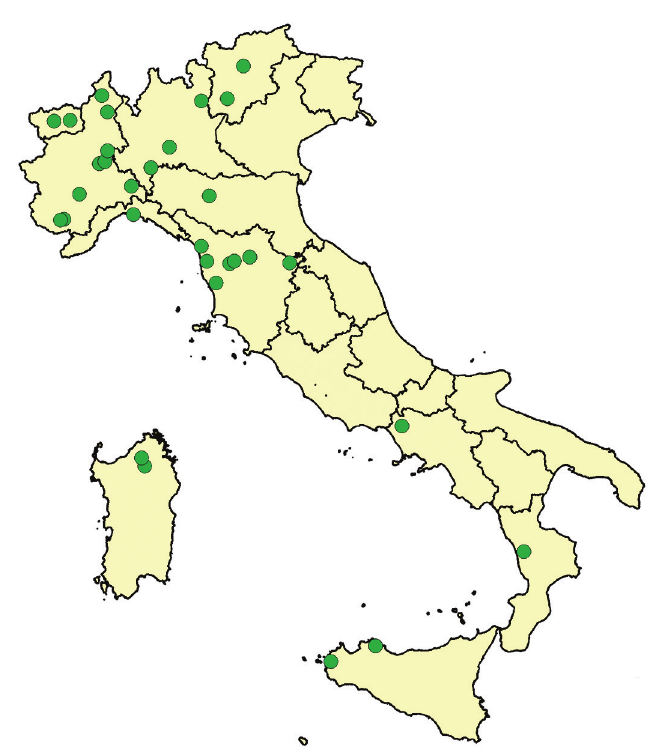
Figure 1. Distribution of the 34 surveyed Italian private